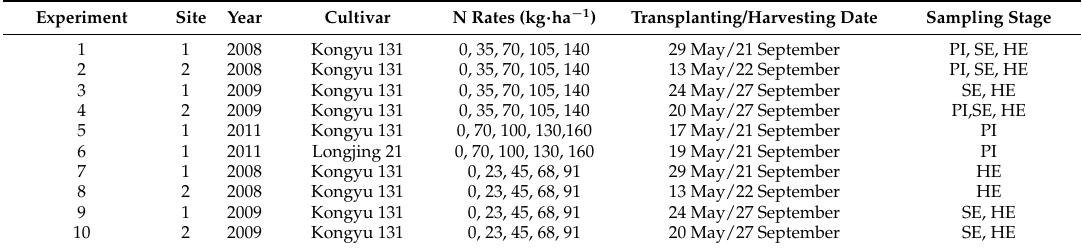
Table 1. Details of the nitrogen rate experiments conducted from 2008 to 2011 in Jiansanjiang, Heilongjiang Province, Northeast